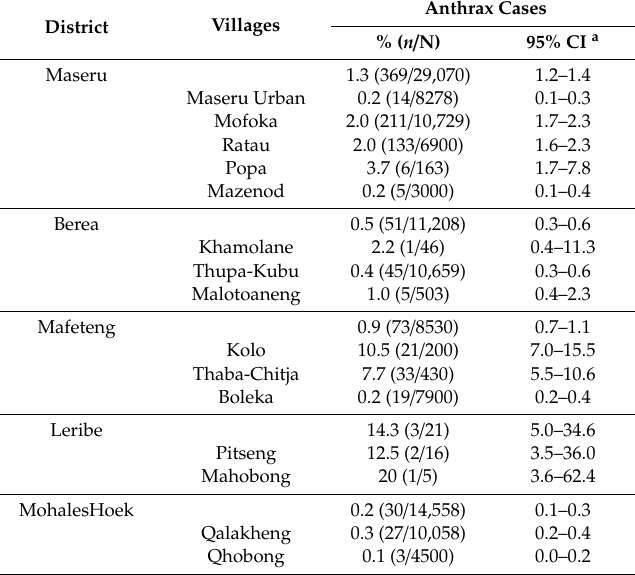
Figure 5. Distribution of anthrax cases in five Lowlands districts of Lesotho from 2005 to 2016. The Leribe district had the highest (14.3%) proportion of cases, while the Mohale’s Hoek district reported the lowest proportion of cases (0.2%) (Table 2). Among the villages, Mahobong had the highest proportion of cases (20.0%), followed by Pitseng (12.5%) and Kolo (10.5%) (Table 2 and Figure 6). Table 2. Proportion of anthrax cases over the population at risk per district and village from 2005 to 2016 in Lesotho.